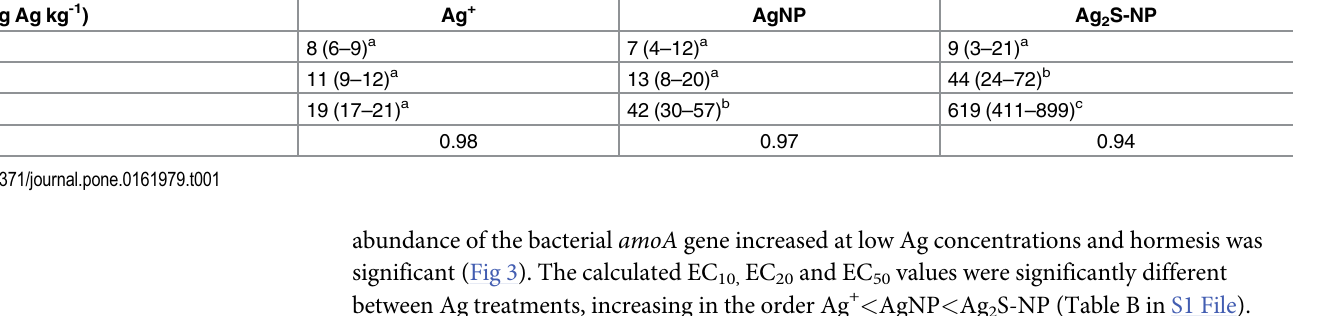
Table 1. Silver concentrations (mg Ag kg soil -1 ) that correspond to a 10%, 20% and 50% reduction in soil nitrate production compared to the con- trol (EC 10, EC 20 and EC 50 , respectively). Mean values are shown with 95% confidence intervals in parentheses. For a given EC x , significant differences ( p < 0.05) between Ag treatments are indicated by different superscript letters. EC (mg Ag kg -1